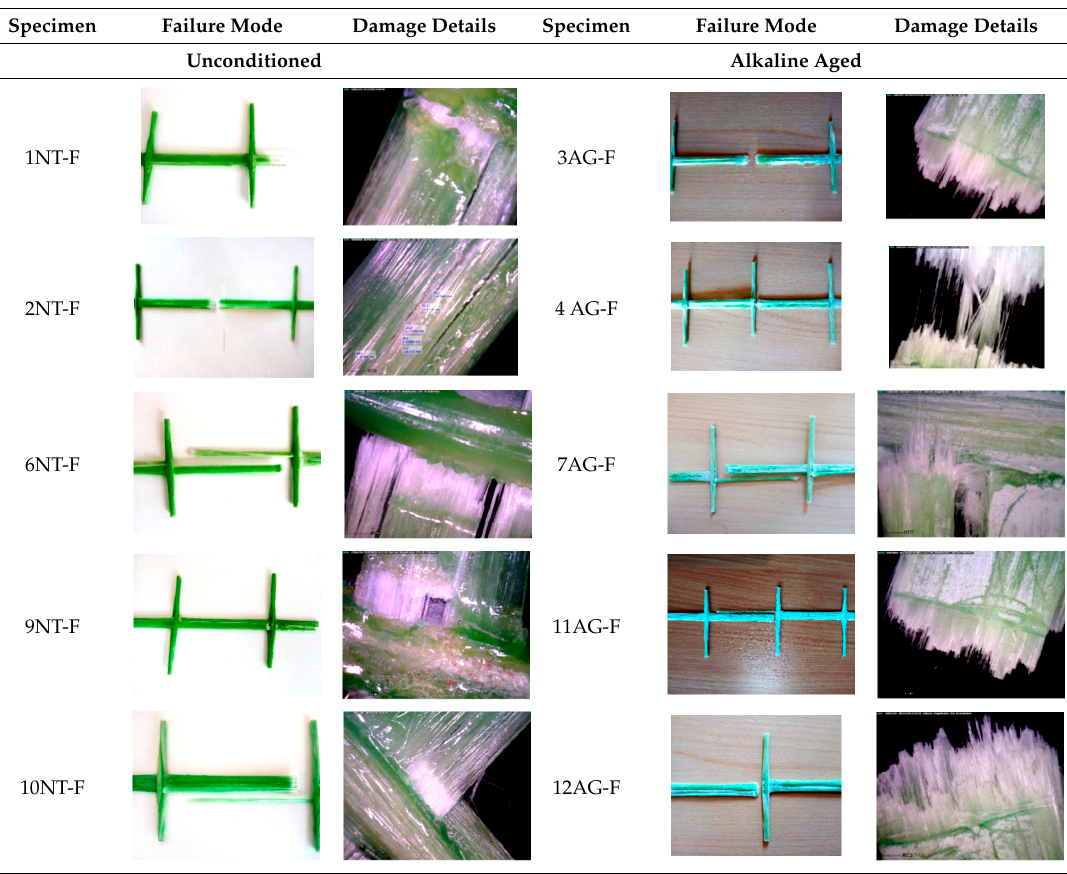
Table 6. Failure modes of unaged and aged GFRP under fatigue